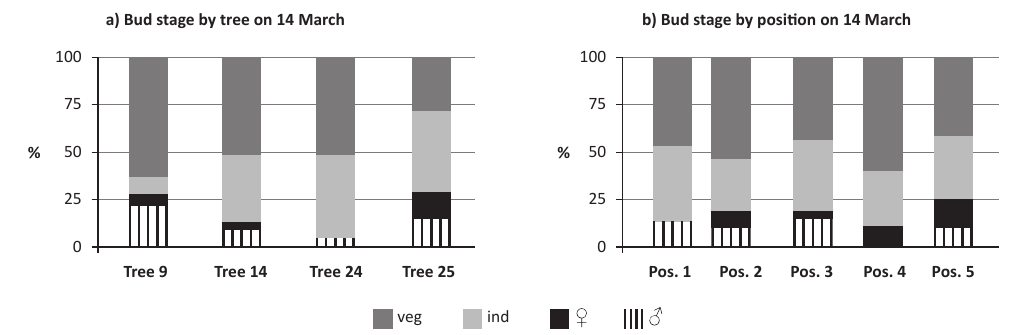
FiGure 4. Quantification of bud determination comparing tree and bud positions (pos.) on a branch (veg - vegetative, ind - undifferentiated, /veg - primordia of female inflorescences with vegetative buds, primordia of male inflorescences at 14 March 2010).